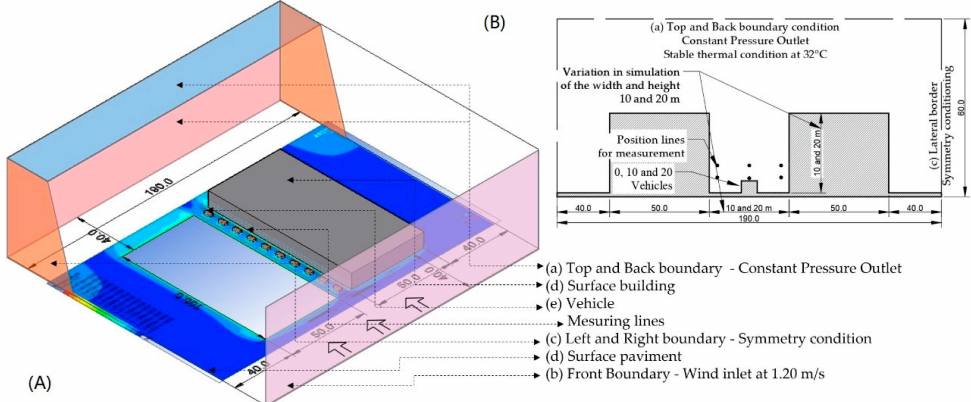
Figure 4. ( A ) Isometric indicating boundary conditions. ( B ) Section with general measurements for data location, as well as the general volume of the